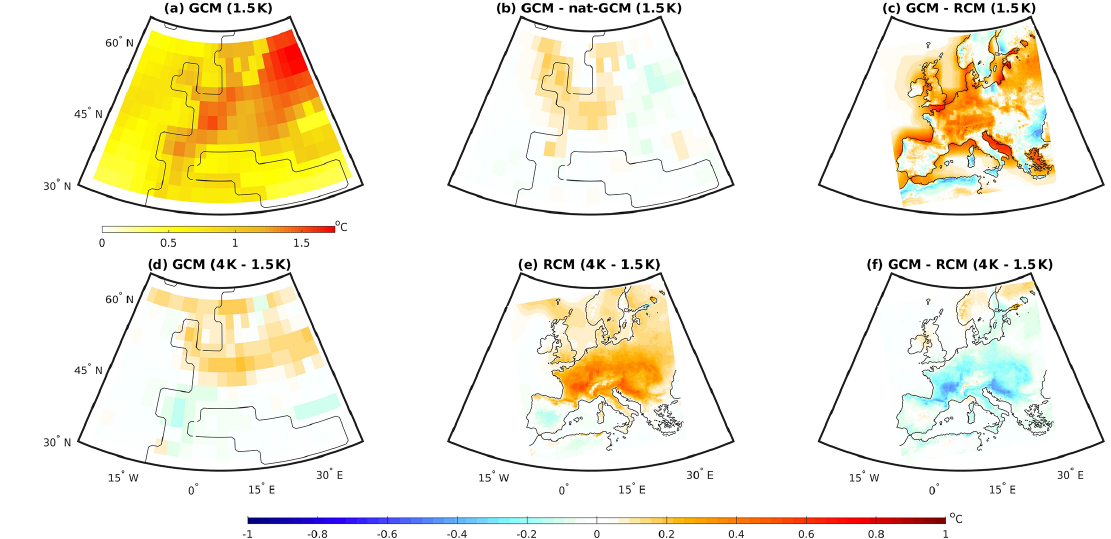
Figure 5. Summer surface air temperature (SAT) variability in (a) the GCM at 1.5K warming, (b) difference between GCM and the nat-GCM at 1.5K warming, (c) difference between the GCM and RCM at 1.5K warming, (d) the GCM at 4K warming, (e) the RCM at 4K warming, and (f) difference between the GCM and RCM at 4K warming. Before the RCM is subtracted from the GCM, the GCM is regridded to the RCM grid. We use an 11-year window around each warming year to analyse the data. SAT variability is calculated as the standard deviation across the pooled summer (mean over June, July, and August each year) SAT from all ensemble members and all years in the time period. The forced response in the mean state is removed by removing the ensemble mean for each summer from each ensemble member prior to the variability calculation. Continental borders are shown for each model’s native grid.